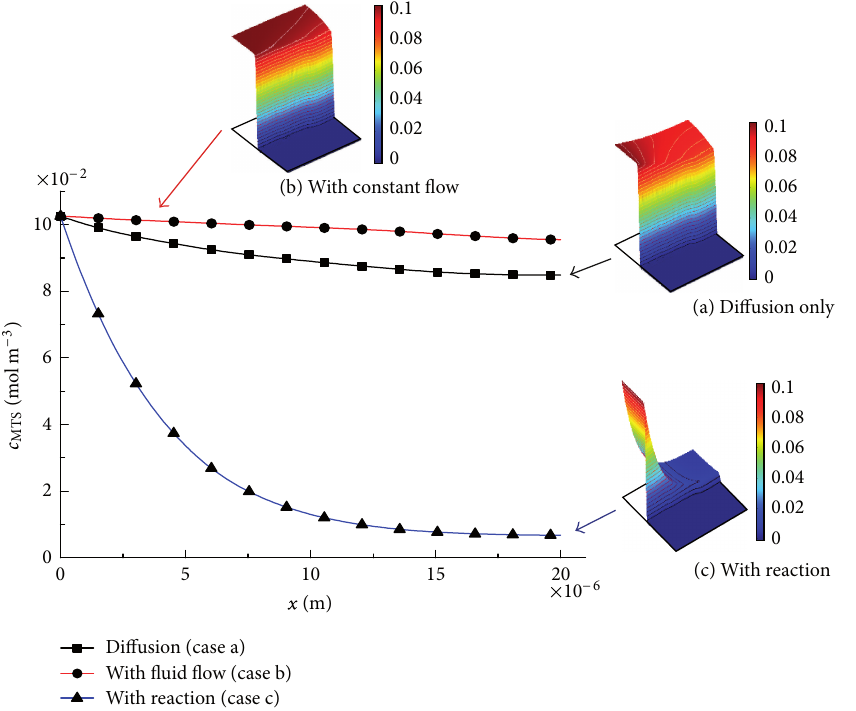
F 6: e effect of �uid and chemical reaction on